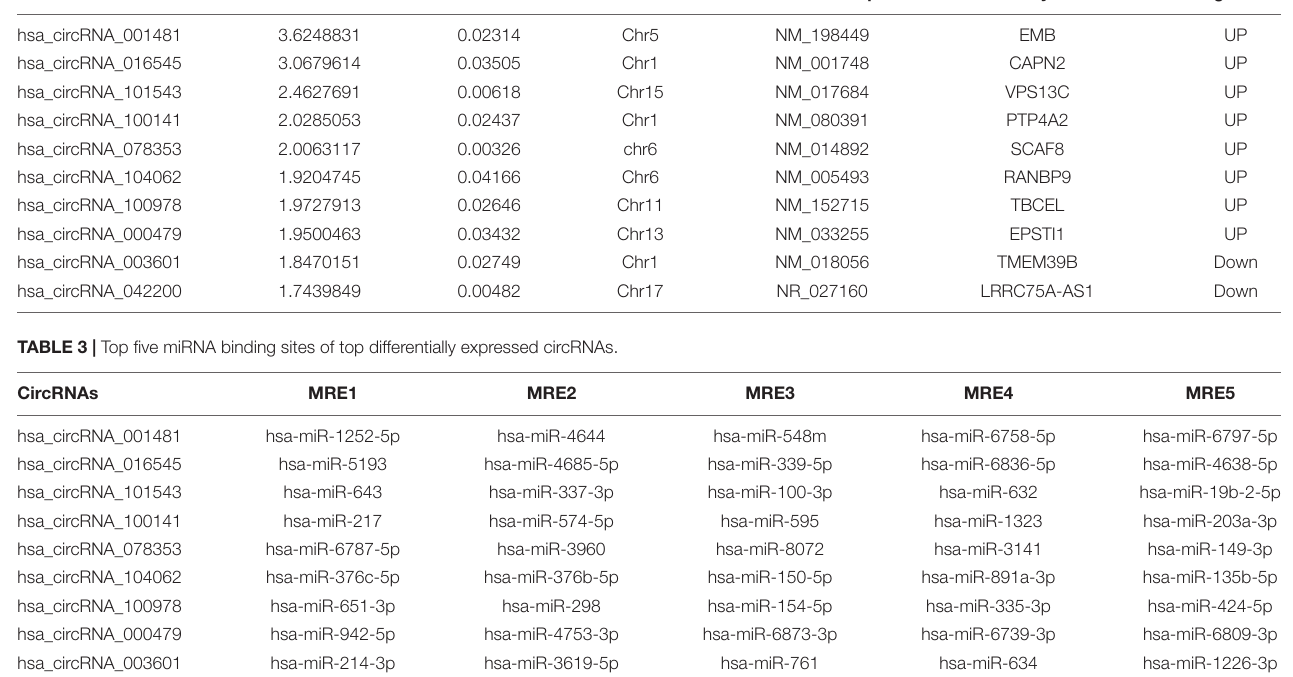
FIGURE 2 | Hierarchical cluster analysis presents the expression profiles of each group. High relative expression is indicated by red color while low relative expression is in green color. Expression profiles of similar groups were clustered and represented through the dendrogram. Heat maps of each comparison show the higher relative expression of SCD samples as compared to controls. Control samples (C276 and C281) and test samples (SCD: T275, T287, and T288 and aMCI: T274). TABLE 2 | Top 10 (upregulated and downregulated) differentially expressed circRNAs ranked by fold change. CircRNA FC